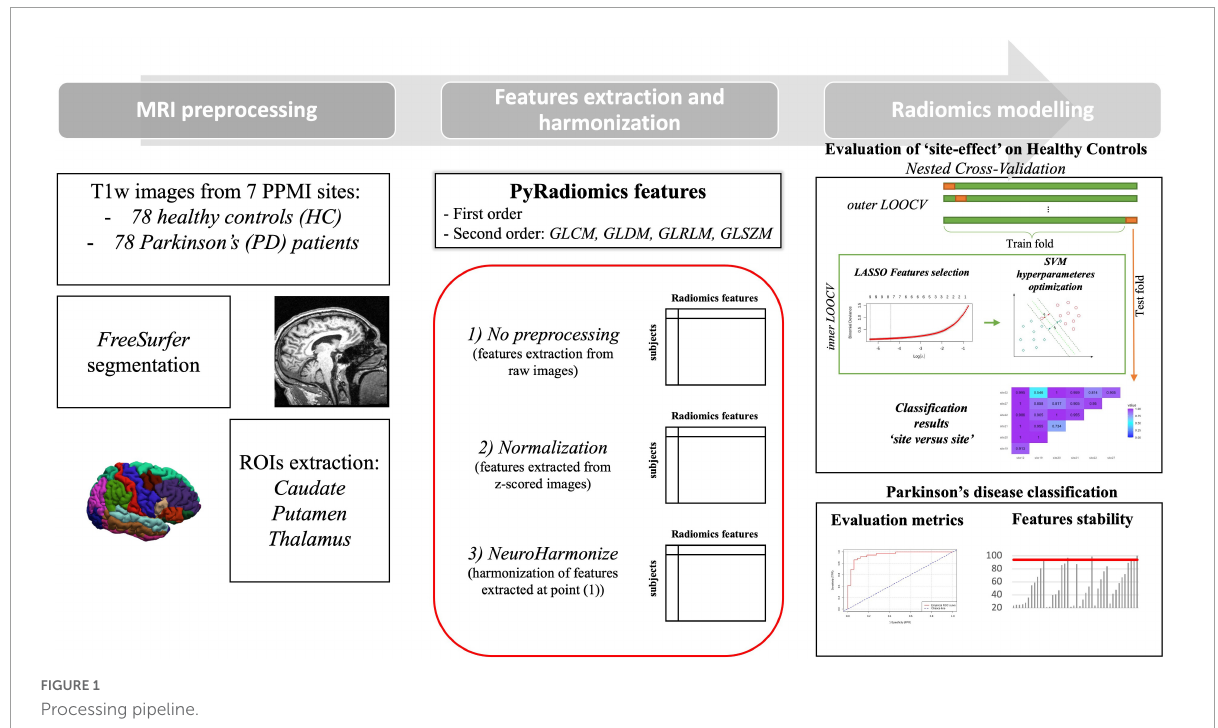
FIGURE1 Processing